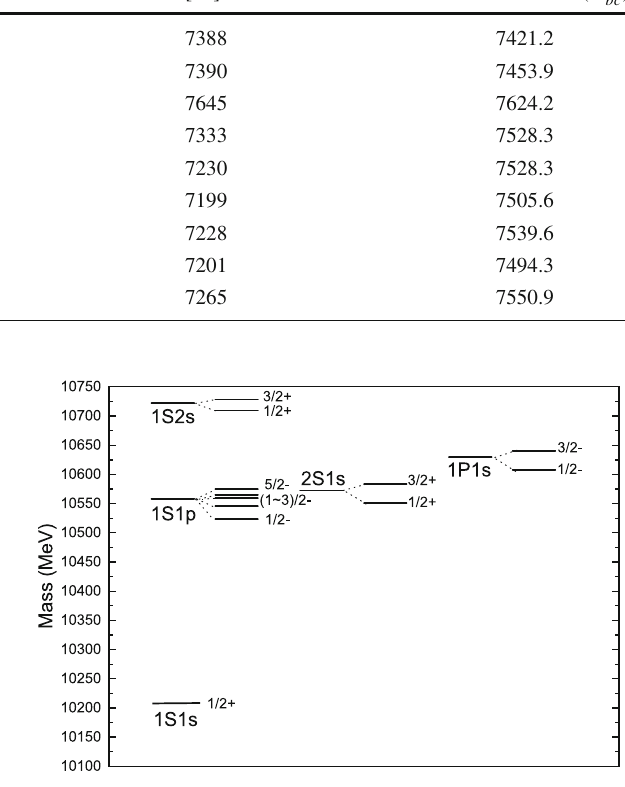
Fig. 1 Mass spectrum (in MeV) of the (cid:2) cc baryons, corresponding to the Table 10. The horizontal dashed line shows the (cid:4) c D threshold